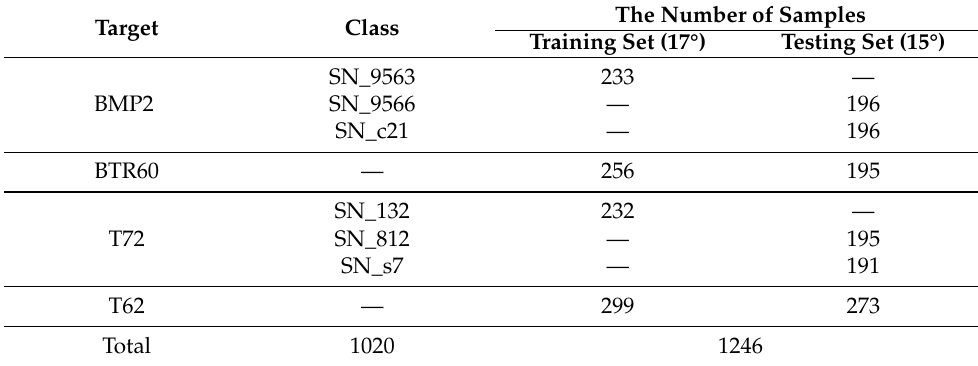
Table 1. Details of our MSTAR dataset.